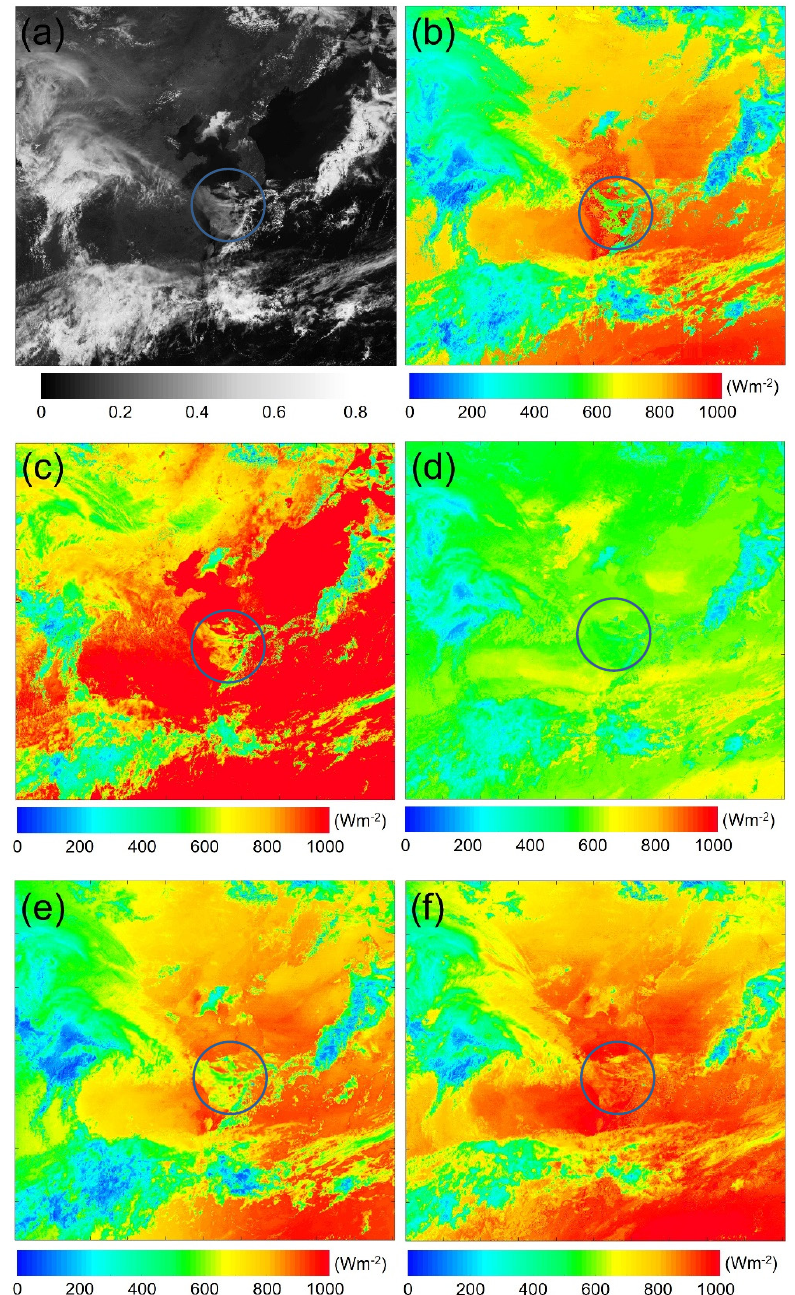
Figure 6. Comparison of solar radiation maps simulated using ( a ) the pattern determined from the visible band on 03:00 UTC, 15 April 2017 with ( b ) the physical model, ( c ) SVR, ( d ) RF, ( e ) ANN, and ( f ) DNN.